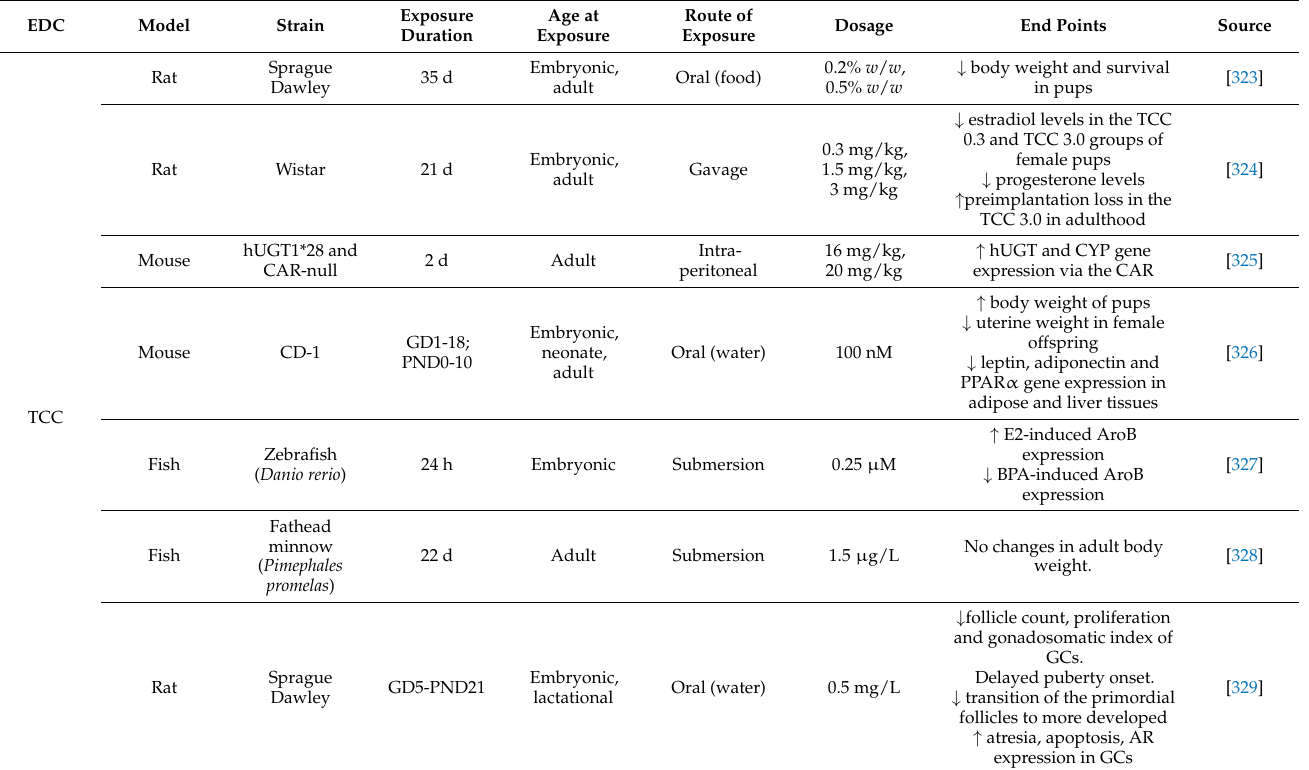
Table 1. The selected developmental and endocrine/reproductive effects of TCC and TCS in ani- mal